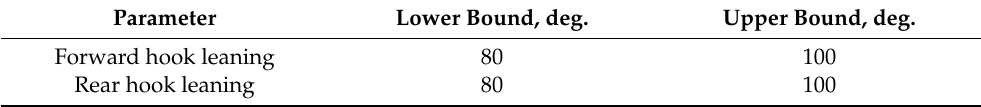
Table 3. Geometrical angular parameters.